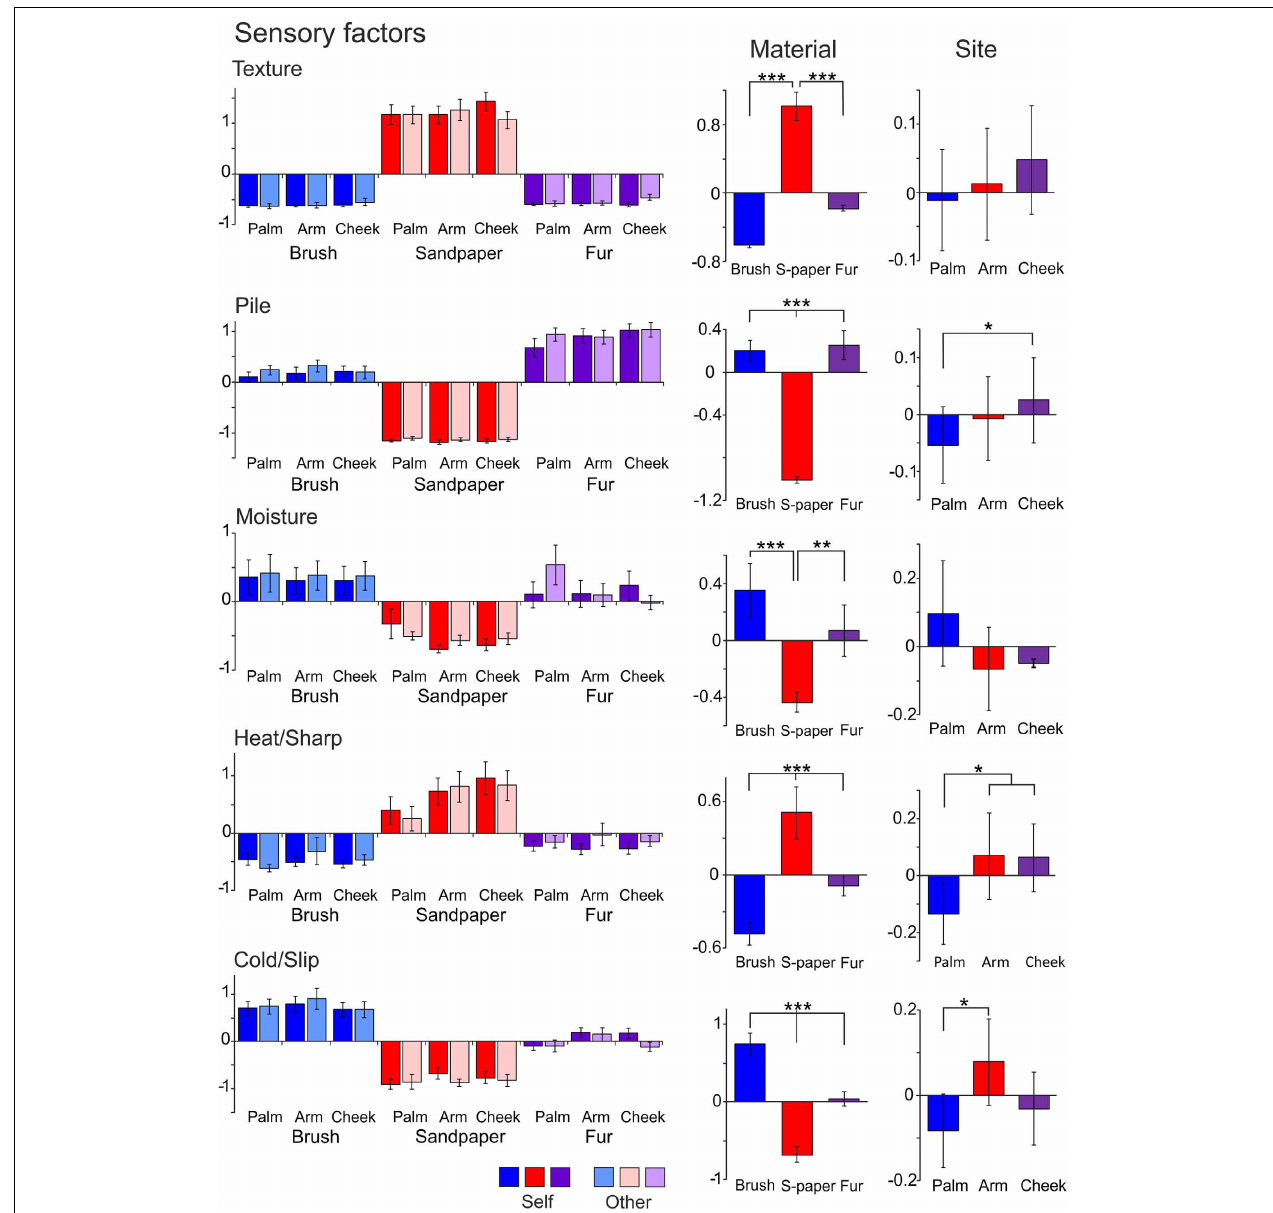
FIGURE 1 | The average scoresfor thesensory factors. Each factor (Texture, Pile, Moisture, Heat/Sharp, and Cold/Slip) is displayed with the average scores forthelevelsofeachcondition(leftgraphs)andtheaveragefortheMaterialand Site conditions on the right side. Significant differences between the levels of